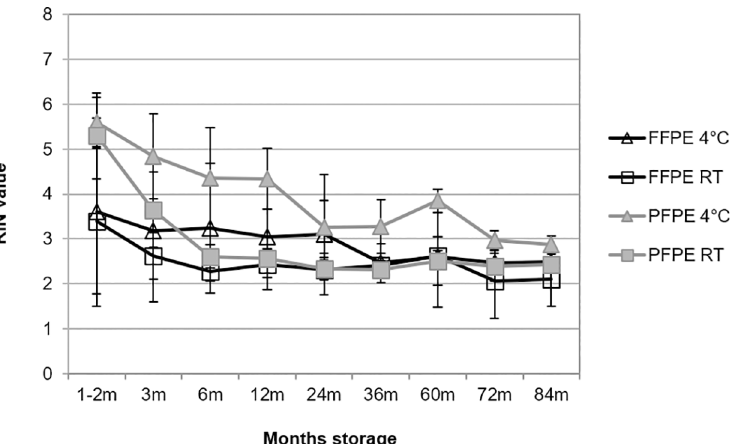
Fig 2. RNA integrity from human PET blocks decreases depending on storage temperature. Analysis of RNA integrity number (RIN) was performed from human PFPE and FFPE tissues using an Agilent Bioanalyzer. PET blocks of different tissue types were stored at room temperature (RT) and 4˚C prior to RNA extraction. RNA was extracted from 8 different cases including four different tissue types (soft tissue, stomach, duodenum, liver) at several time points for up to 84 months (m) of storage (S1 Table). For each time point, fixation method and storage condition the mean RIN value with standard deviation was calculated (total RIN values n = 411).